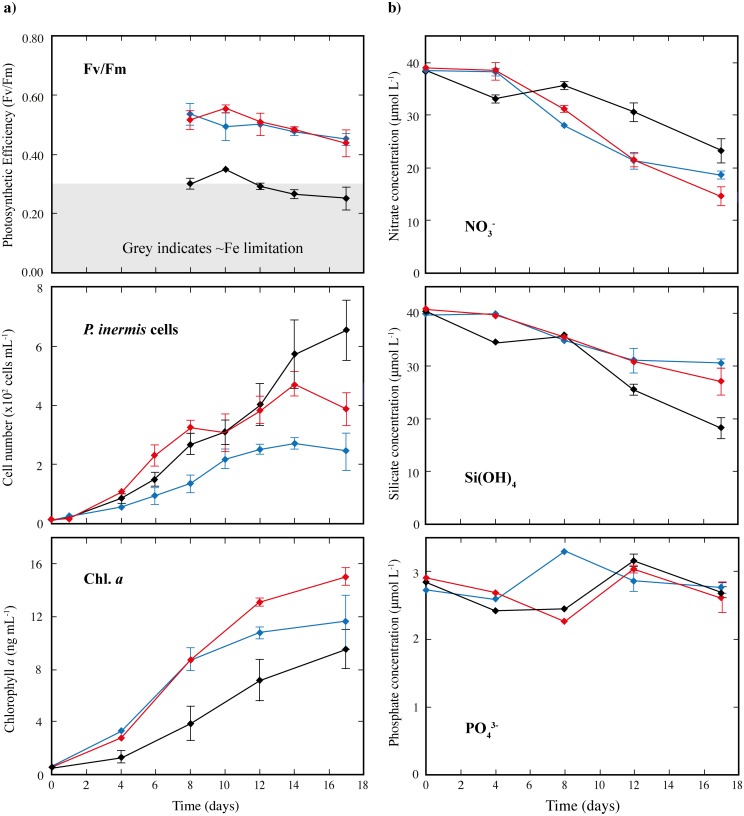
a) The growth of Proboscia inermis under different conditions (control or in response to iron chloride (+FeCl3) or dust (+dust) addition), over 17 days. Photosynthetic efficiency (Fv/Fm), diatom cell number and chlorophyll a concentration are shown. b) Nutrient concentration in different incubations of P. inermis over the course of each experiment. Nitrate (NO3-), silicate (Si(OH4)) and phosphate (PO43-) are shown. For each parameter initial values were measured in the canister, before subdivision of the culture medium into 5 bottles, and these are shown for time = 0. After this, the mean of measurements in the replicate bottles is shown (n = 3 for 2–10days, n = 5 at 17 days), with error bars denoting ± 1SD (where bigger than the size of the symbol). The grey bar indicates Fv/Fm values that are considered to represent cells under stress.